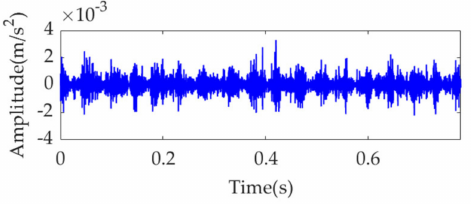
Figure 13. Sampled vibration dataset in the pinion fault